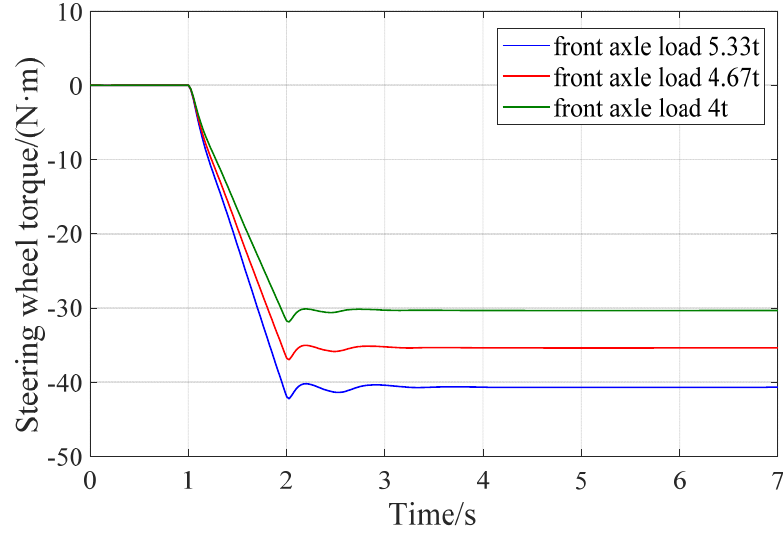
Figure 1. Steering wheel torque under different front axle loads at µ = 0.8.